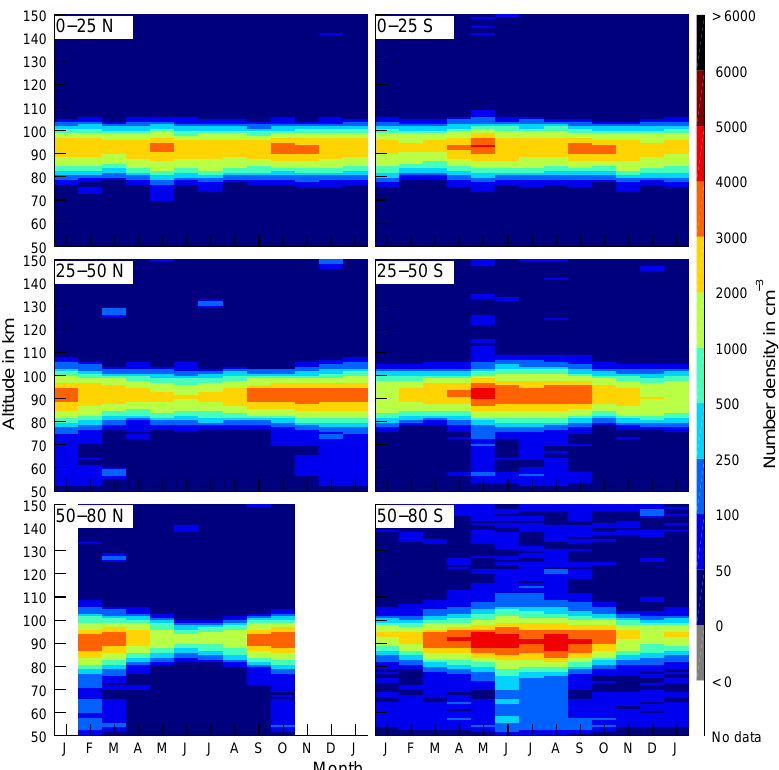
Figure 15. Seasonal variation of the vertical Na density profile for low, middle and high latitudes.